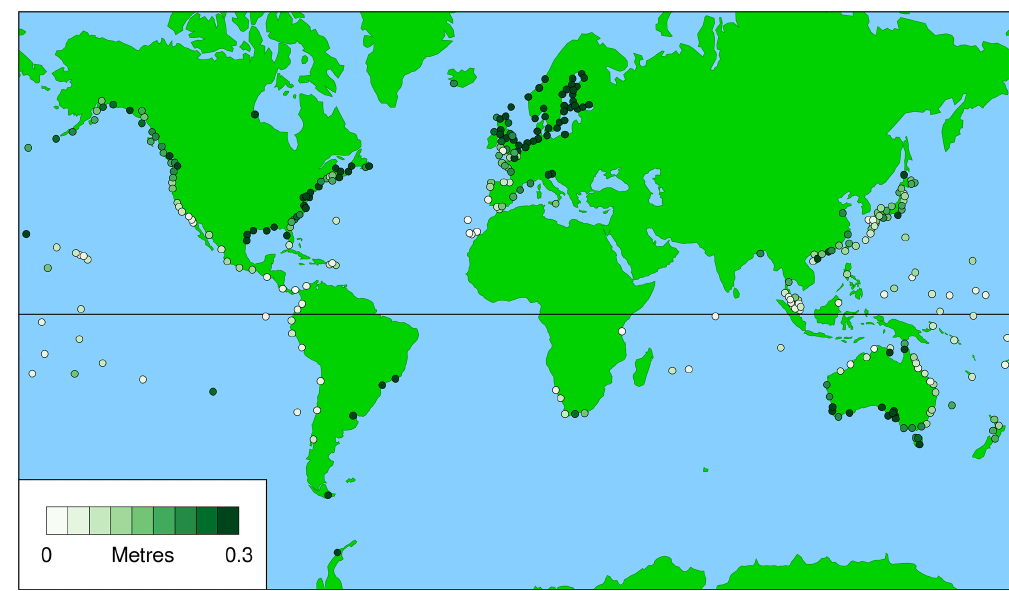
Figure 1. Averaged first metric , which is height of highest observed sea level above observed maximum on day of highest predicted tide for the year, for civil days ( o c (I oc (j,k),j,k) − o c (I pc (j,k),j,k) ), averaged over all valid years, j .